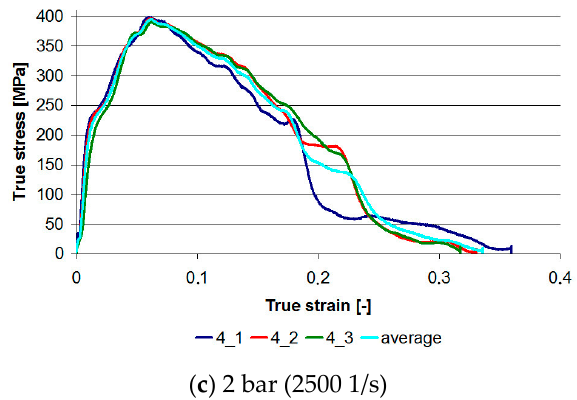
Figure 6. True stress–true strain graphs for three loads in dynamic compression tests at ambient temperature. ( a ) 21 °C—samples 2_1 to 2_3 ( b ) 21 °C—samples 3_1 to 3_3 ( c ) 21 °C—samples 4_1 to 4_3.